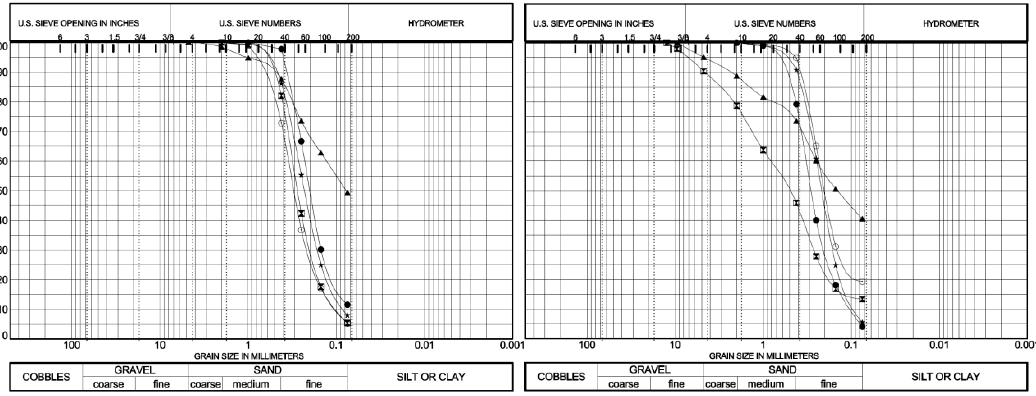
Figure 1. Sieve analysis results of sabkha soil.